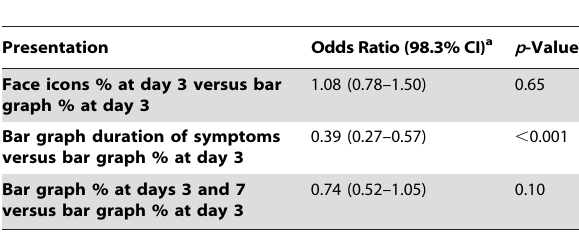
Table 5. Odds ratios for deciding to go to the doctor on the first decision for each group compared to the more fully informed second decision for the other four groups.